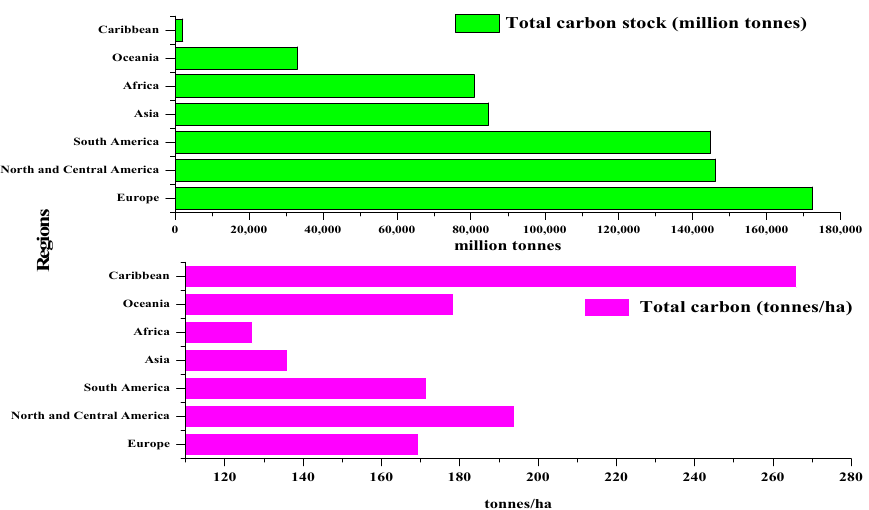
Figure 6. Comparing forest carbon stock by region total carbon stock (Mt), tons/ha 2020, Source; (FAO, 2020).